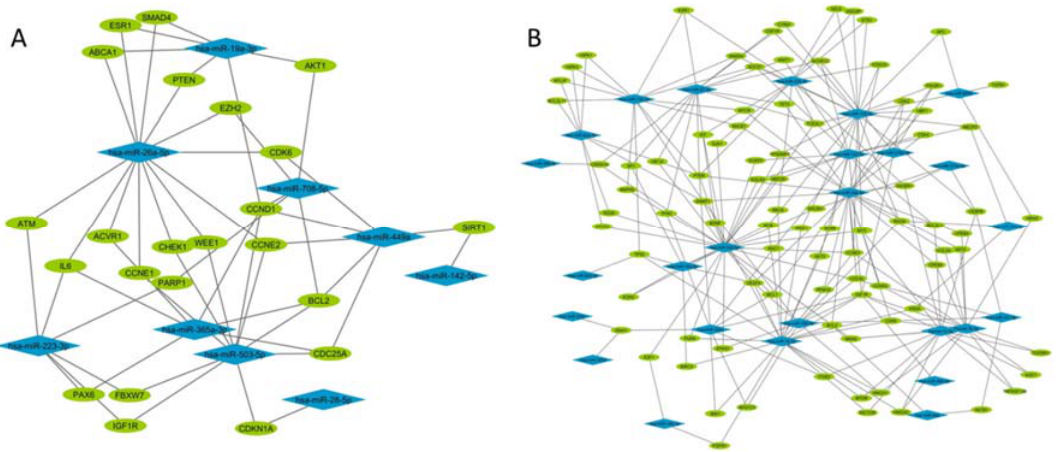
Figure 4. In silico analysis of miRNA cargo of EVs obtained before and 5 h after the first dose of fingolimod. ( A ) Representation of miRNAs (blue diamonds) and target genes (green ovals) interaction network of downregulated and ( B ) upregulated miRNAs 5 h after the first dose of fingolimod. 2.4. 30% of sncRNA Cargo of EVs Is Commonly Expressed in All